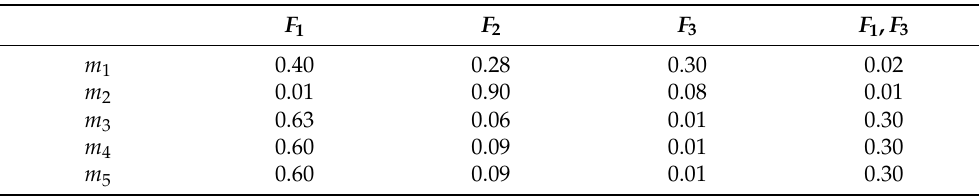
Table 7. BPAs in Application